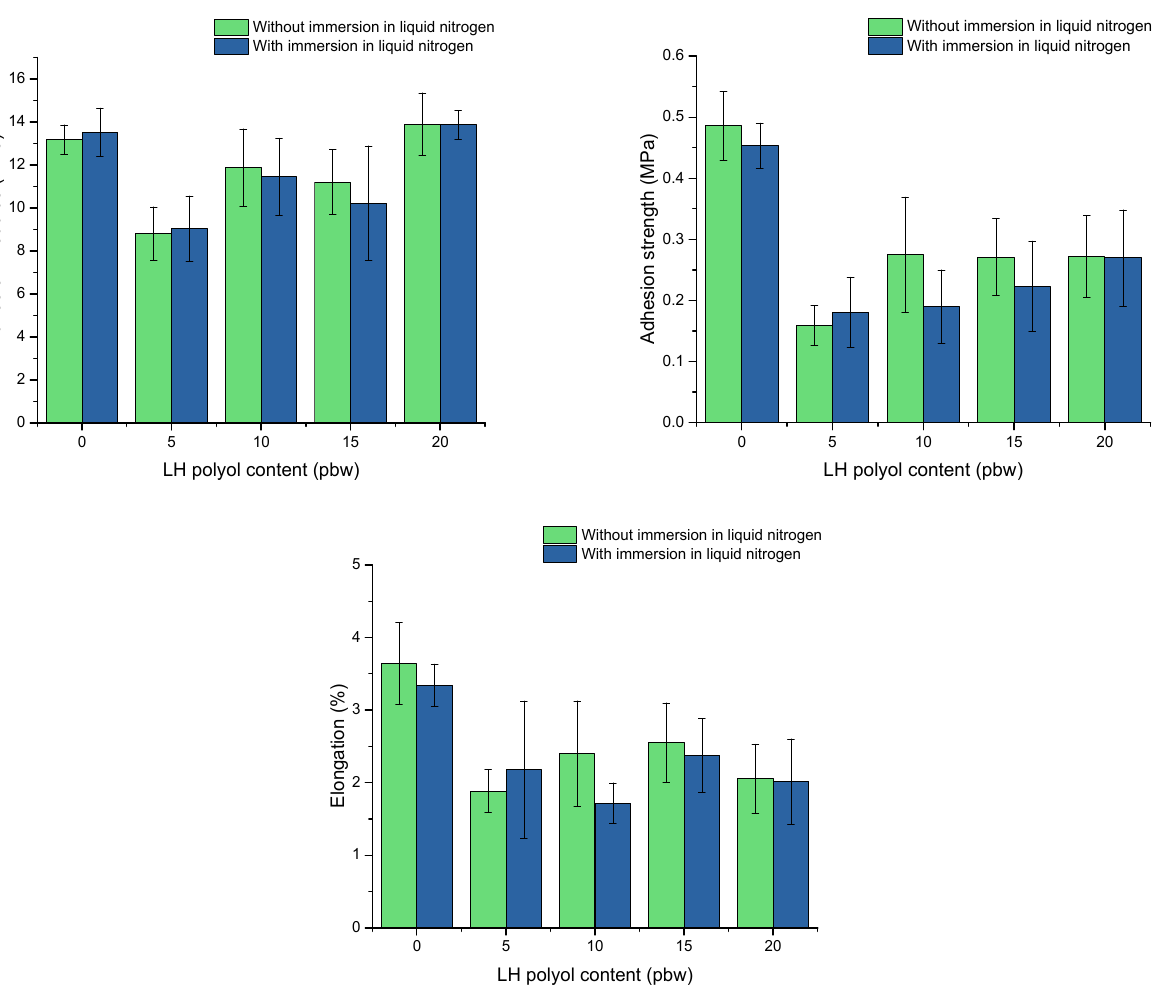
Figure 4. Adhesion modulus, strength and elongation at break of rigid PUR foams without and after immersion in liquid nitrogen.